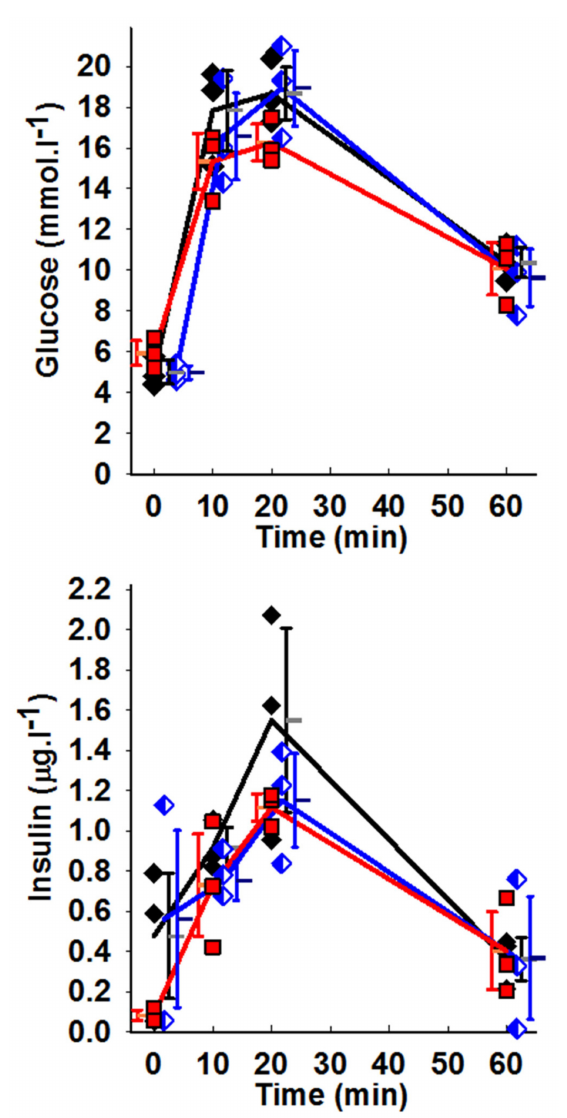
Figure 4. Time course of glycemia and insulin release —i.e., intraperitoneal glucose tolerance test and insulin time course, performed as described in Ref. [8], after a single glucose dose. Mice were treated for two-weeks with hyaluronic-acid implants with no glucose (black symbols represent sham operation); 100 µ L (blue symbols) and 200 µ L of implants (red symbols). N = 3 mice at each time point. Note for rather exhausted fasting insulin levels (at time zero) for treatment with 200 µ L of